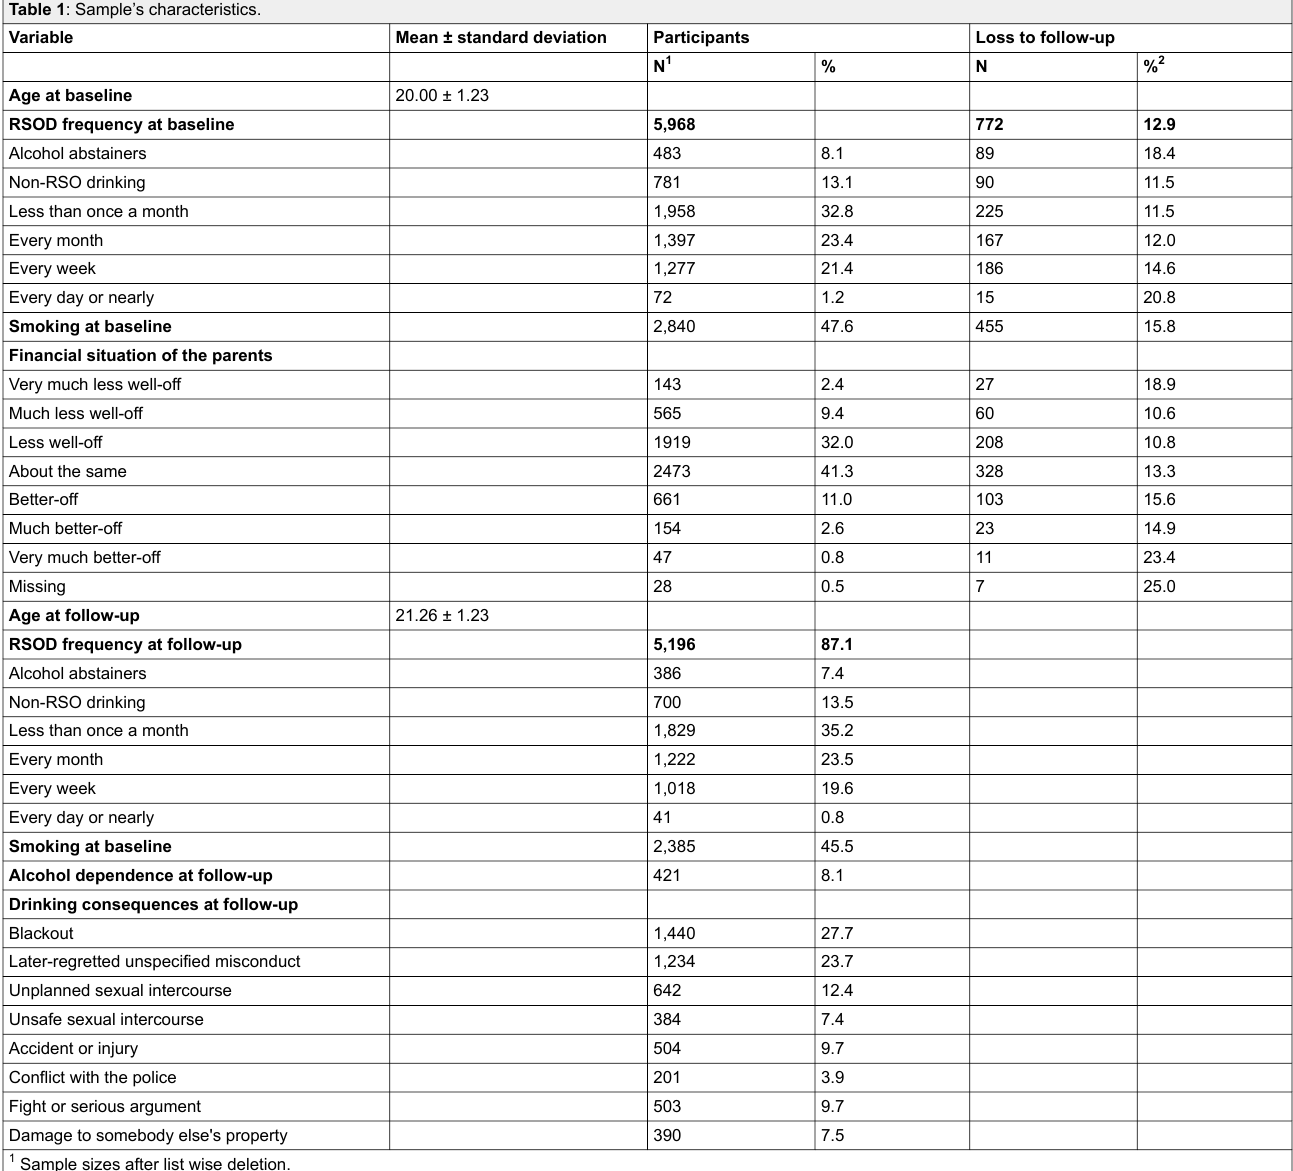
Table 1 : Sample’s